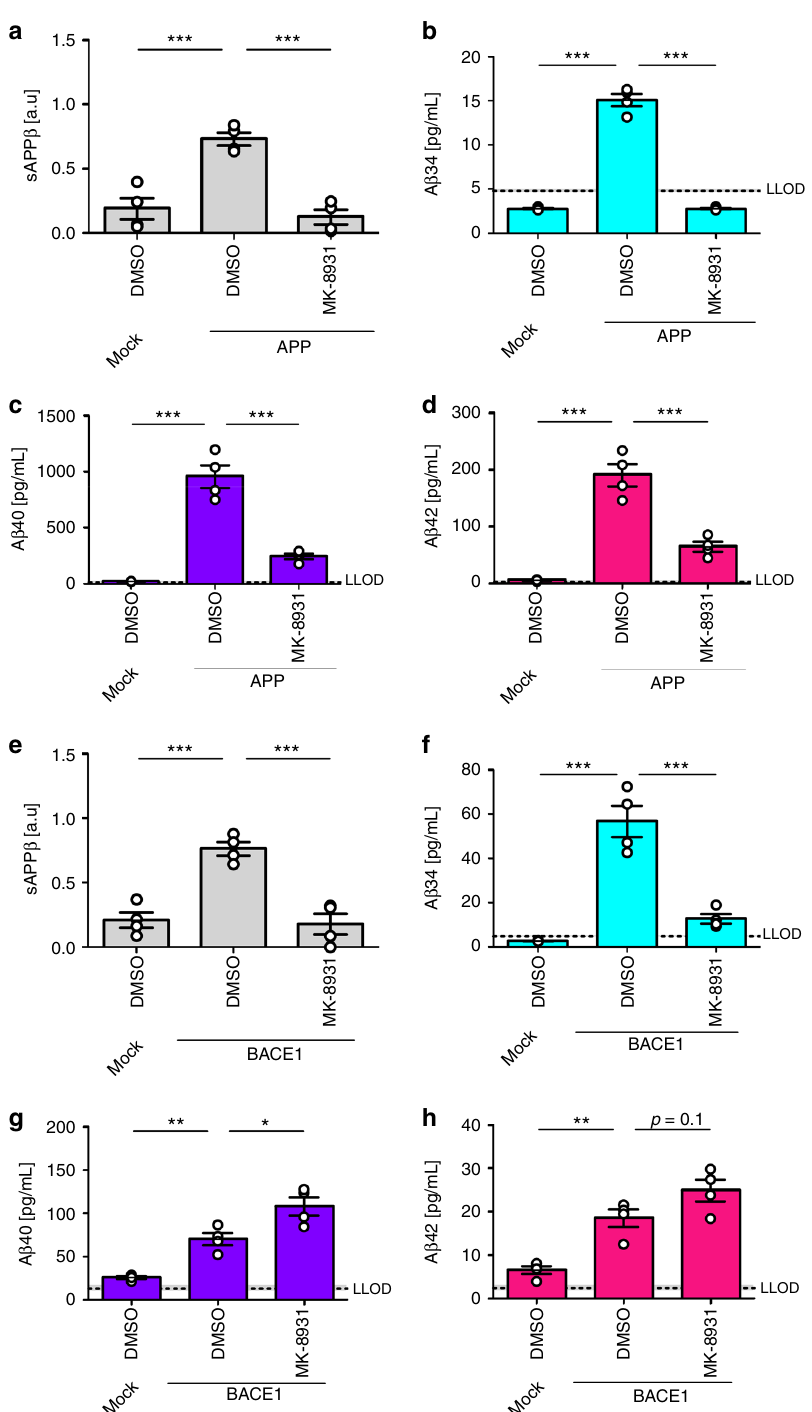
Fig. 4 Surplus of APP or BACE1 affect BACE1 inhibition. Cleavage of APP was analyzed by western blot and ultra-sensitive MSD assays. Absolute or relative amounts of products were quanti fi ed from SH-SY5Y cells stably expressing APP695 ( a – d ) or BACE1 ( e – h ). Quanti fi cation of relative amounts of sAPP β ( a , e ), and absolute amounts of A β 34 ( b , f ), A β 40 ( c , g ), and A β 42 ( d , h ). Data were collected from four independent experiments. Bars and error bars indicate mean ± s.e.m. Tukey ’ s post-hoc tests were performed for pairwise comparisons; selected comparisons are highlighted *** p < 0.001, ** p < 0.01, * p < 0.05. a sAPP β , one-way ANOVA, F (2, 9) = 26.6, p < 0.001, b A β 34, one-way ANOVA, F (2, 9) = 296.1, p < 0.0001, c A β 40, one-way ANOVA, F (2, 9) = 65.9, p < 0.0001, d A β 42, one-way ANOVA, F (2,9) = 59.4, p < 0.0001, e sAPP β , one-way ANOVA, F (2, 9) = 25.4, p < 0.001, f A β 34, one-way ANOVA, F (2,9) = 45.3, p < 0.0001, g A β 40, one-wayANOVA, F (2, 9) = 30.8, p < 0.0001, h A β 42, one-way ANOVA, F (2, 9) = 23.3, p <